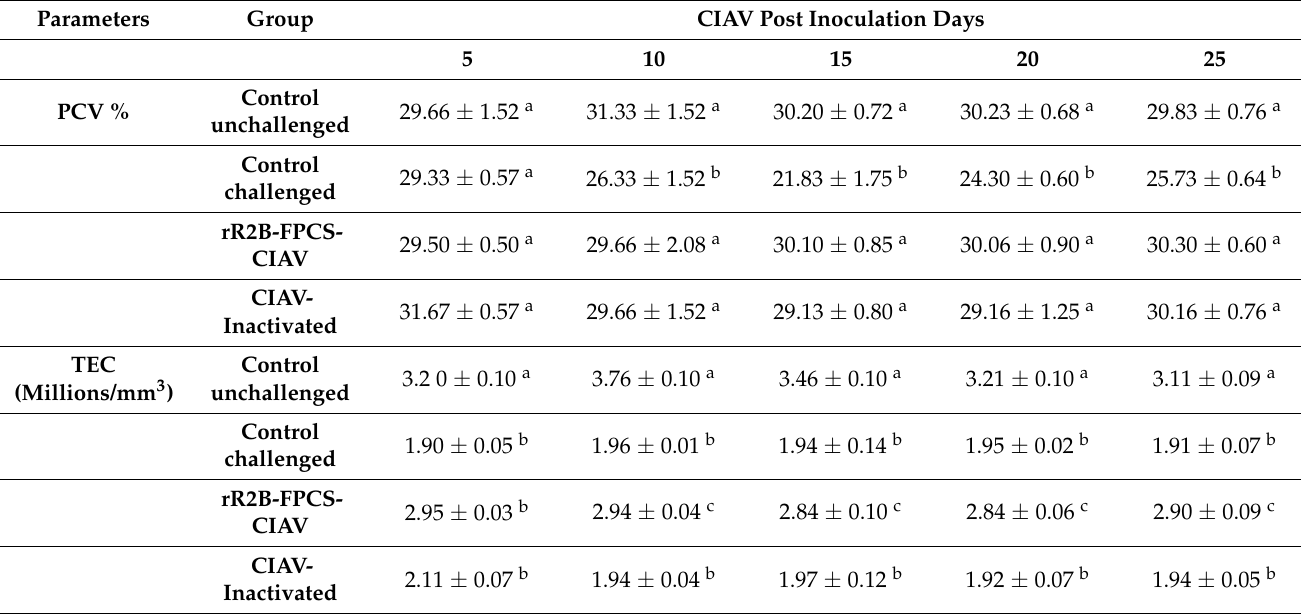
Table 1. Effect of CIAV inoculation on packed cell volume (PCV), total erythrocytes count (TEC), total leukocyte count (TLC),